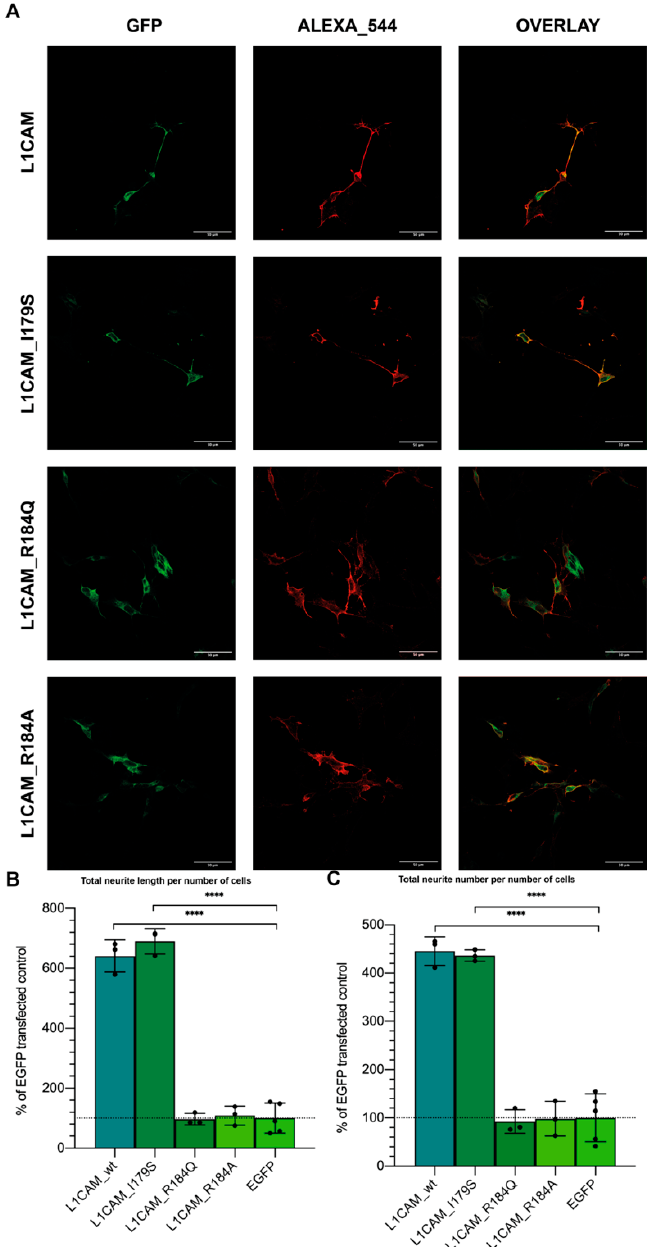
Figure 3. Neuritogenesis of proliferating SH-SY5Y cells transfected with L1CAM derived CDS. ( A ) Confocal images of GFP-tagged wt or mutant L1CAM-transfected cells. Treatment with secondary antibody was performed on nonpermeabilized cells. ( B ) Total neurite length per number of cells,